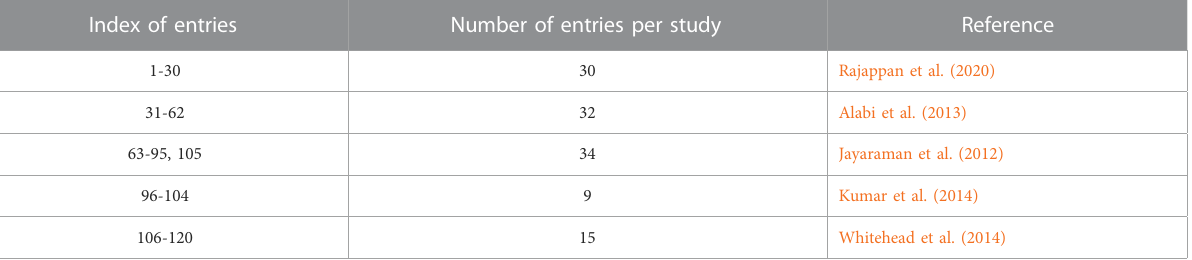
TABLE 1 Summary of data set. The entries represent either distinct lipids or the same lipid but with different PEG mol% and/or knockdown